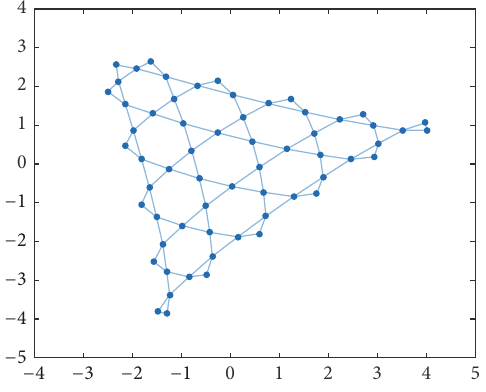
Figure 6: Regular triangular oxide network